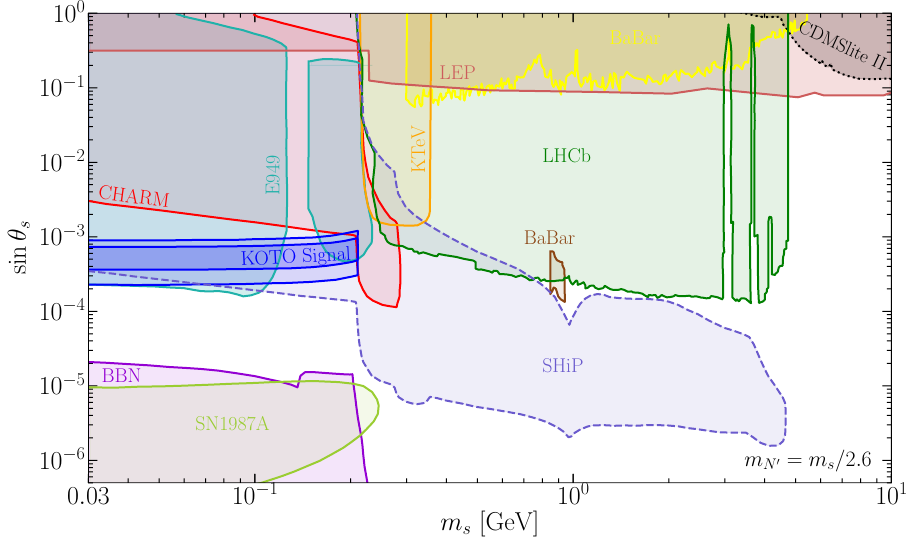
Figure 7 . Constraints on a light singlet mediator, in the m The experimental bounds, along with the projected sensitivity, are the same as in (cid:12)gure 6 and taken from ref. [69]. The strongest direct detection constraint derived for our model comes from CDMSlite II experiment [80] and is shown with the black dotted